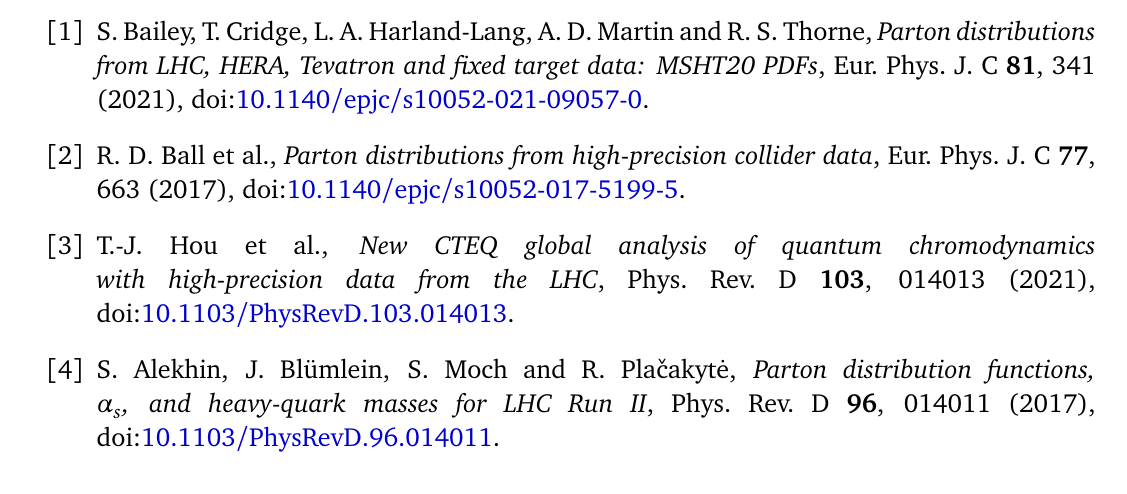
Figure 8: Predictions for single top p to CMS